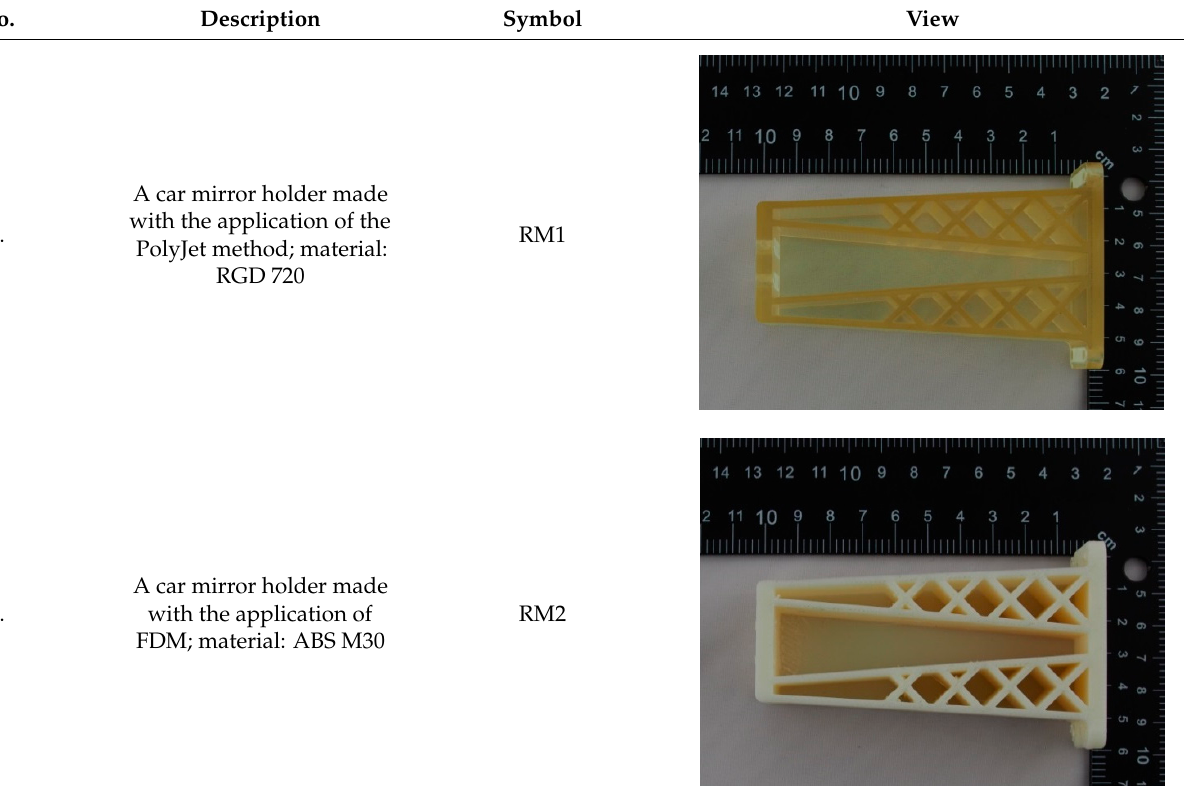
Table 2. Photographs from visual control.